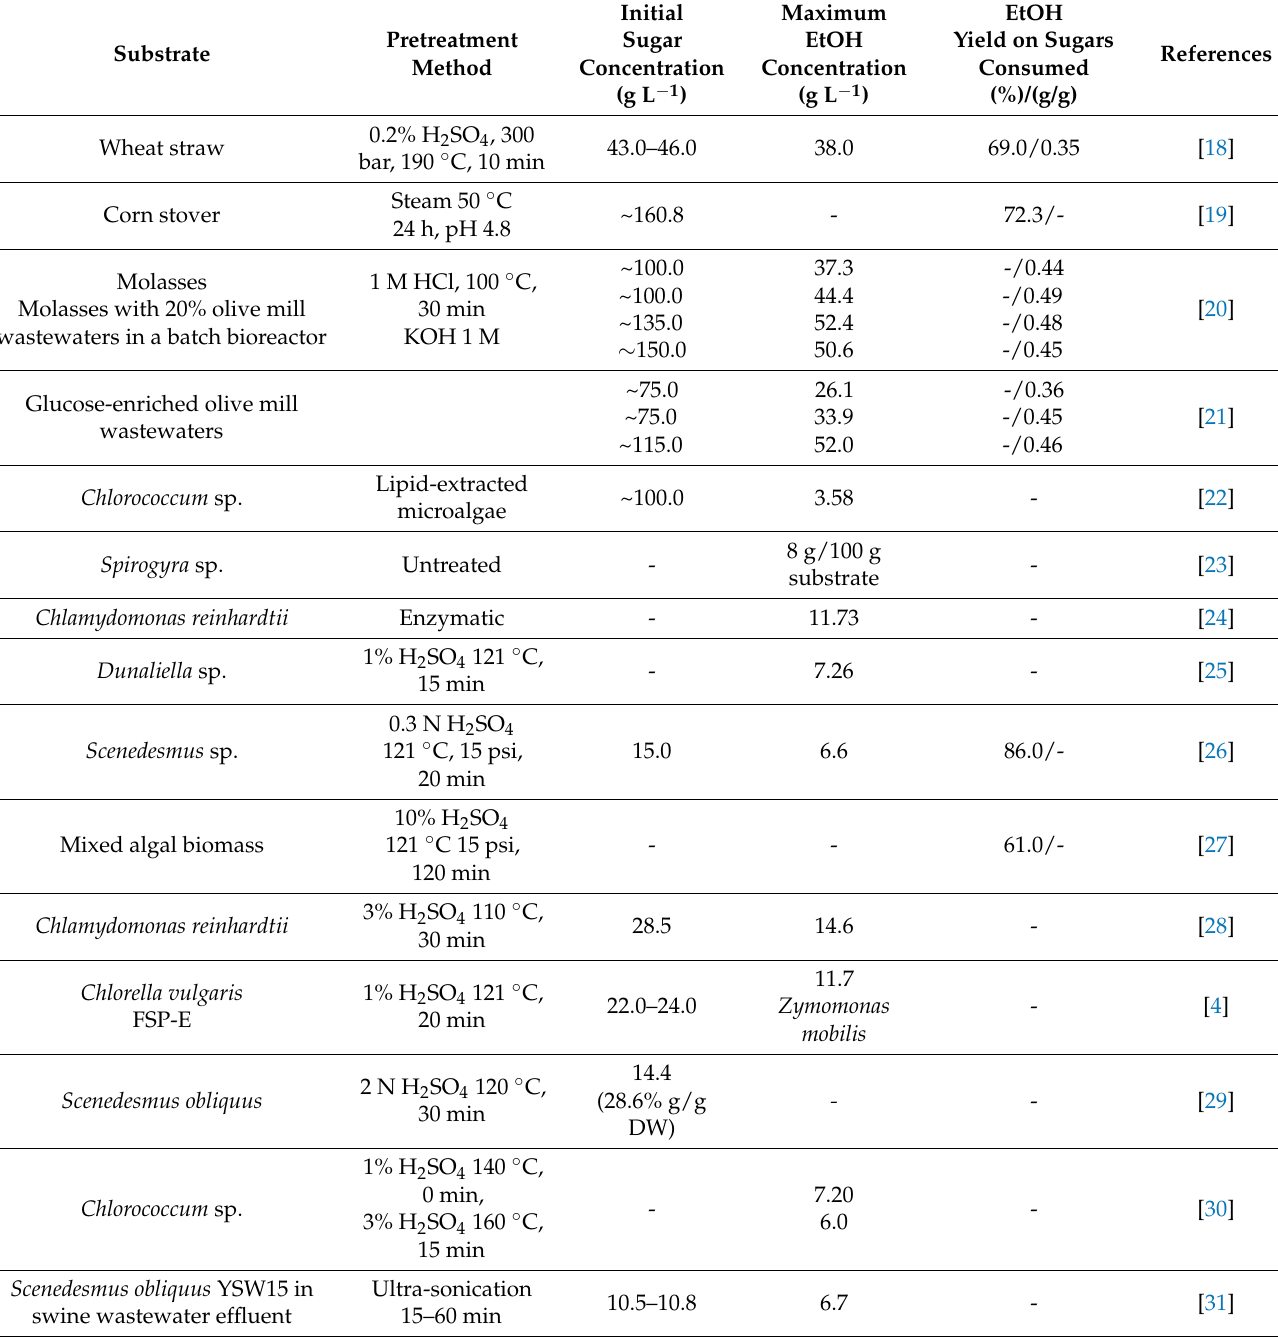
Table 1. Biomass types, pretreatment methods, initial sugar concentrations, ethanol production and yields recorded in the